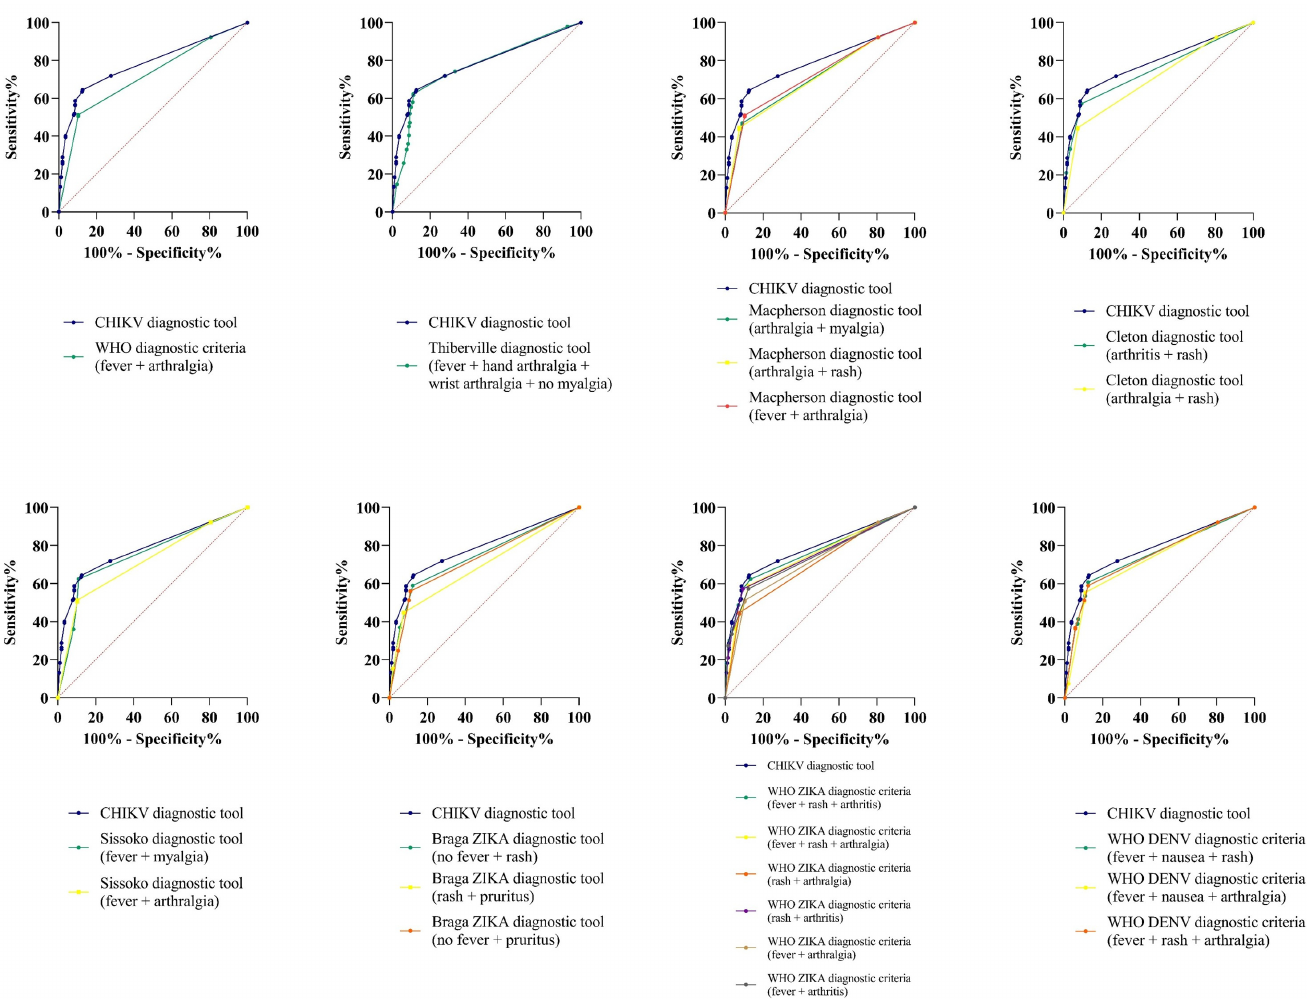
Figure 6. ROC curves of multiple diagnostic and screening tools in CHIKV, DENV and ZIKAV. ROC: Receiver operating characteristic; CHIKV: Chikungunya virus, DENV: Dengue virus; ZIKAV: Zika virus. Table 5. Performance of di ff erent diagnostic tools in our con fi rmed CHIKV infected patients. Sensitivity